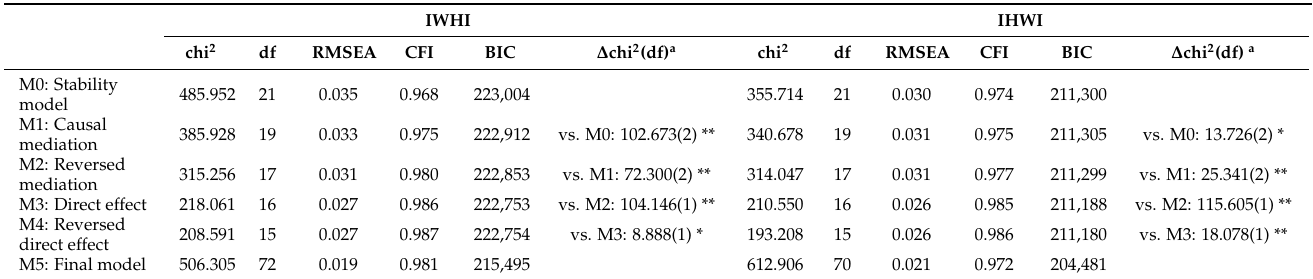
Table A1. Fit indexes and model comparisons for WTC, IWHI/IHWI, and exhaustion (unbalanced panel; n = 17,596–17,918).